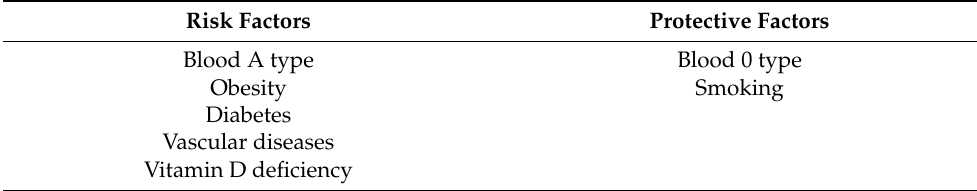
Table 1. Risk and protective factors of preeclampsia and